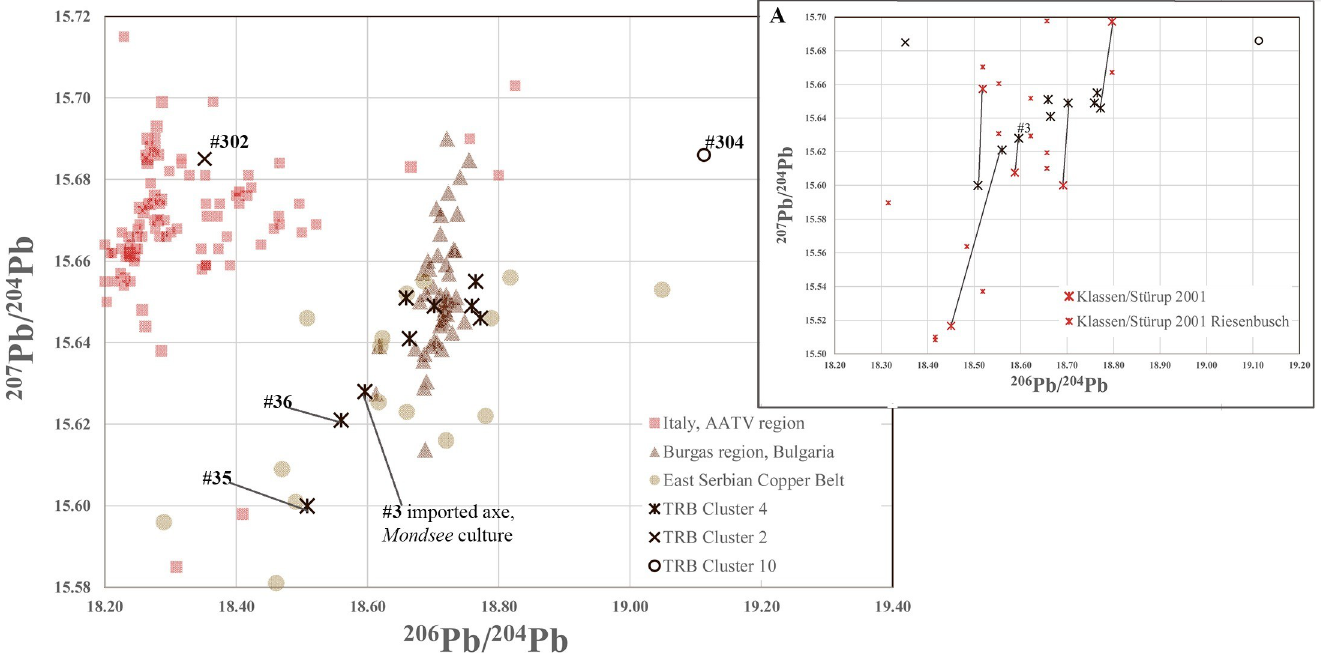
Fig 3. 206 Pb /204 Pb and 207 Pb/ 204 Pb isotope plot of the copper flat axes discussed, with comparative plot (A) indicating the difference of measurements between this study and published ones [14], obviously problematic in their 207 Pb/ 204 Pb ratios. The ore data are from: Italy AATV mining region [32,73–75],Serbian copper deposits [72,76],Bulgarian copper deposits [26,33].